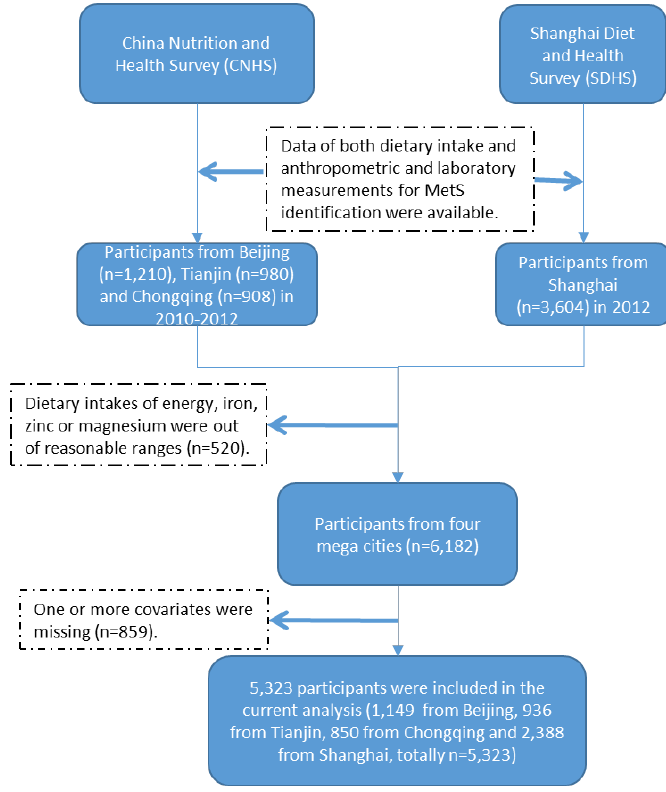
Figure 1. Participants flow chart.